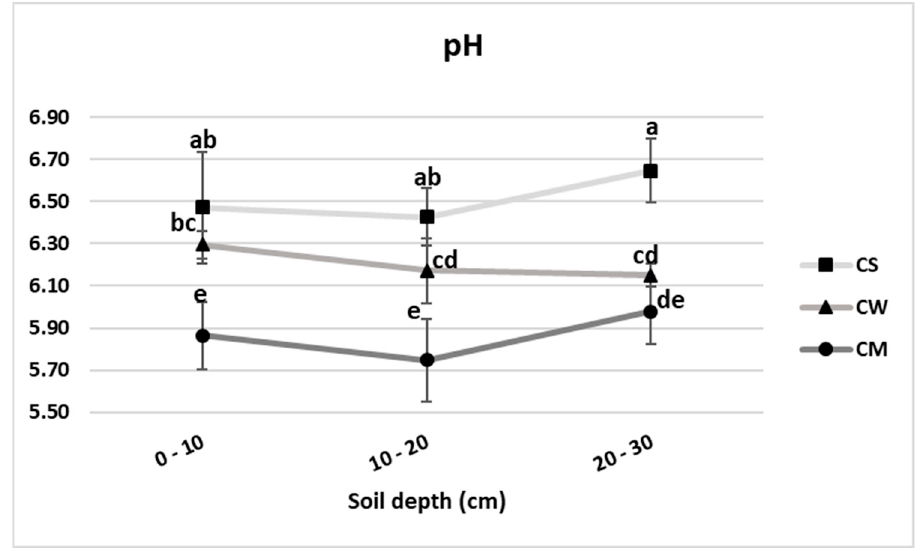
Figure 1. pH values of unplanted soil (CS), soil cultivated by wheat (CW) and soil cultivated by miscanthus (CM) at depths (0–10, 10–20 and 20–30 cm). Values are presented as means ± SD. Differ